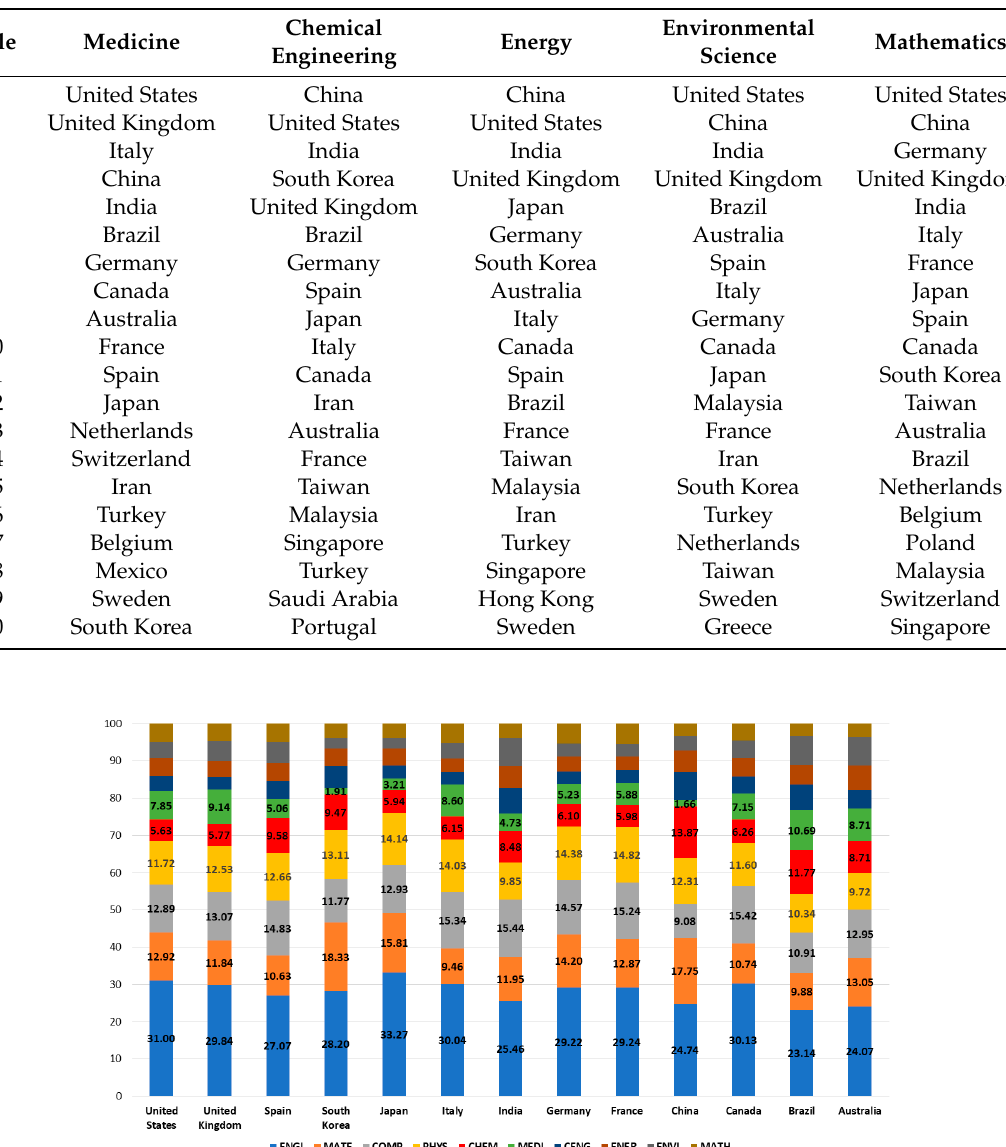
Table 3. Worldwide publications by country on low cost por the categories from 6 to 10.